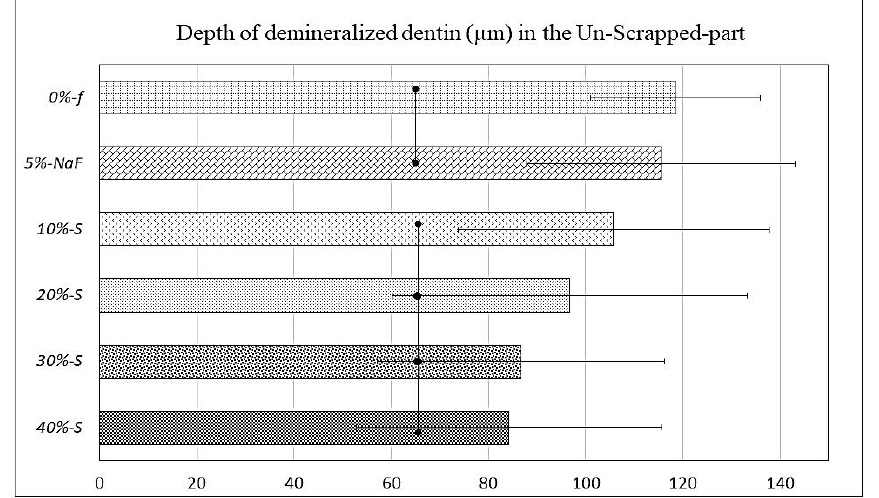
Figure 6. Graph of SS-OCT data representing demineralization depths ( µ m) beneath the DV layer, which were significantly less in all materials of the experimental group compared to the control group; 30%-S and 40%-S had the minimum demineralization. Bars with dots indicate no significant differences ( p < 0.05).